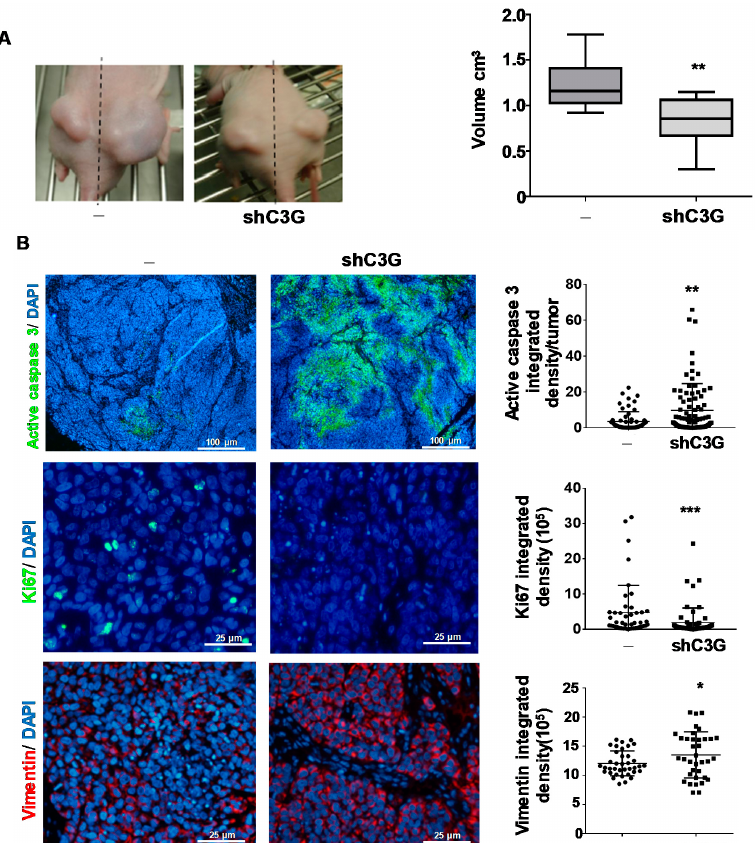
Figure 4. C3G down-regulation interferes with in vivo tumor growth. Xenograft assay was performed by subcutaneously injection of Hep3B (non-silenced ( − ) and C3G knock-down (shC3G)) cells into nude mice flanks. ( A ) Left panel: representative images of mice flanks showing tumors at the end point. Right panel: box plot shows the mean ± S.E.M. of tumor volume in cm 3 at the end point (3 weeks). ( B ) Left panels: representative microscope images of immunofluorescence analysis of active caspase 3 (green), ki67 (green), Vimentin (red) and nuclei DAPI staining (blue) in paraffin-embedded tumor sections. Right panels: scatter plots showing the mean ± S.E.M. of positive area/tumor for each marker analyzed as integrated density/DAPI area. * p ≤ 0.05, ** p ≤ 0.01, *** p ≤ 0.001, vs. non-silenced cells ( − ), using Student’s t -test (for A and for Vimentin in B,) or Mann–Whitney test (for active Caspase 3 and Ki67 in B); n = 2 (two independent experiments with 8 nude mice per experiment).